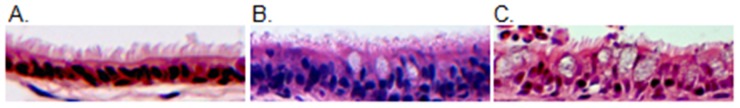
H&E-stained sections of chinchilla middle ears (400× magnification).A. Middle ear mucosa of an uninfected control animal. B. The middle ear of an animal infected with the ΔtoxAvapA mutant for 4 days. Note the characteristic goblet cell hyperplasia associated with a productive NTHi infection. C. The middle ear of an animal infected with the wild type parent strain 86-028NP. The middle ear lumen is at the top of each micrograph.